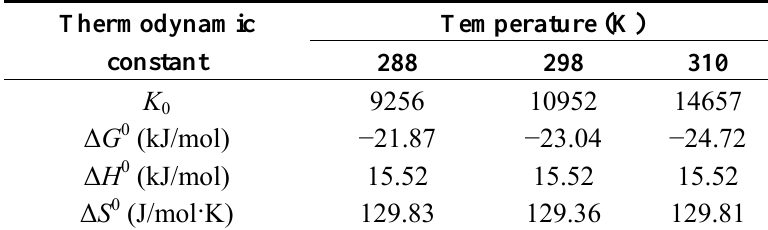
Table 3. Thermodynamic parameters for DOX on